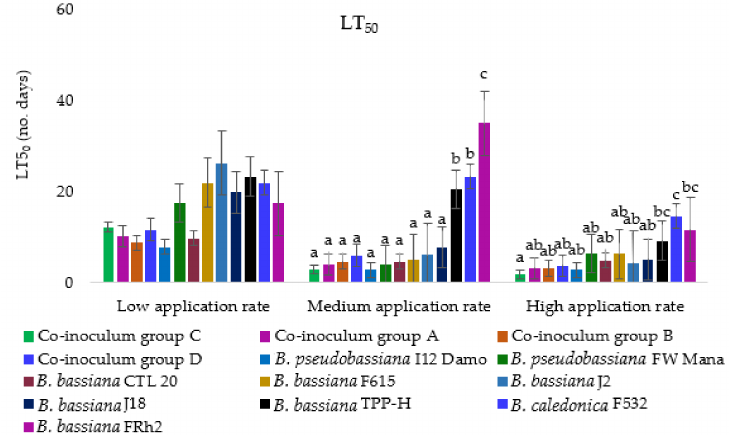
Figure 6. LT50 for the four combinations of isolates and the individual isolates (error bars following letters represent ANOVA; multiple comparisons using Tukey’s HSD test).